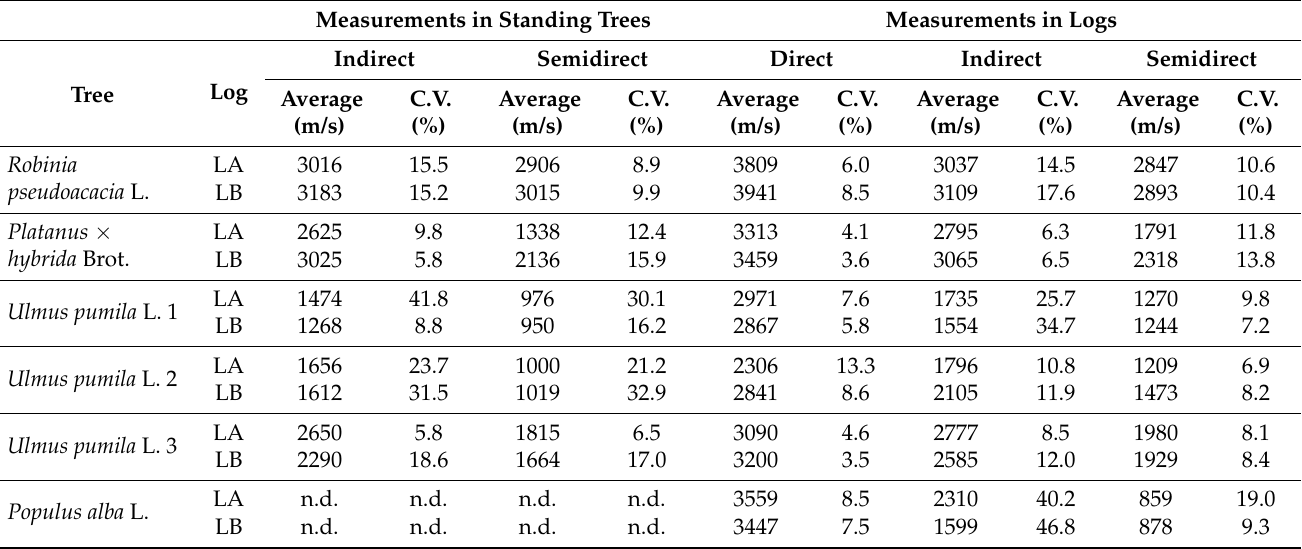
Table 2. Longitudinal velocities obtained using Sylvatest Duo and coefficients of variation. Measurements in Standing